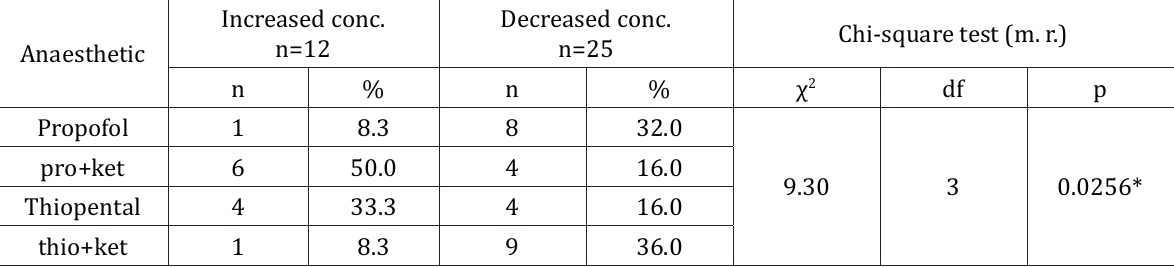
Table 20. Type of anaesthetic used and increased or decreased metalloproteinase concentration in comparison to the starting point and the result of a chi-square (maximal